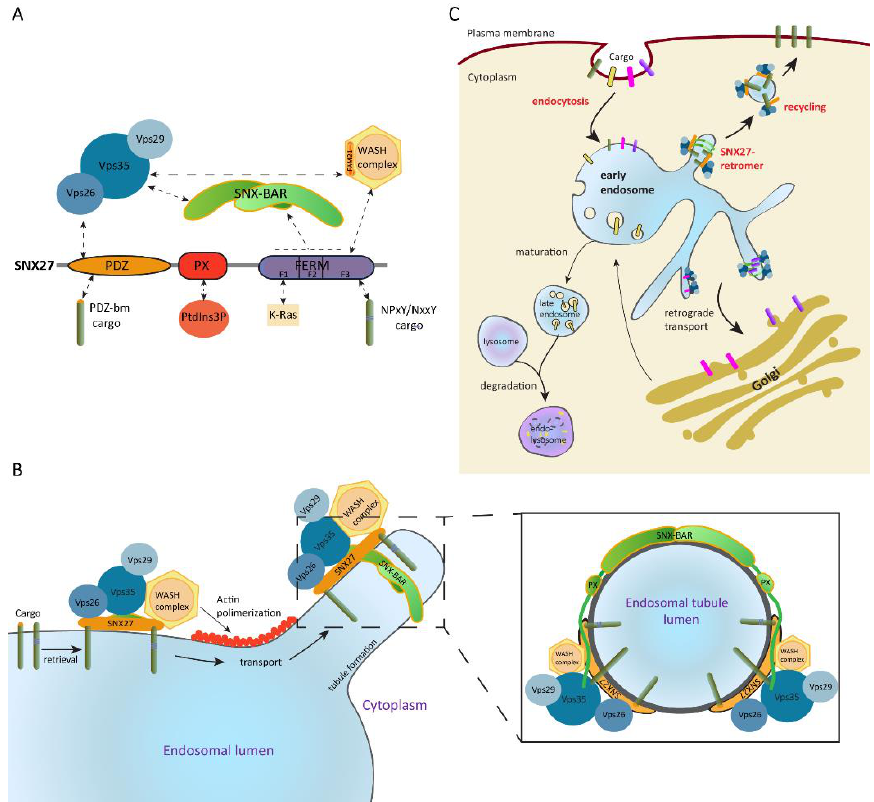
Figure 2. Sorting nexin 27 (SNX27) – retromer architecture and function in intracellular trafficking. ( A )